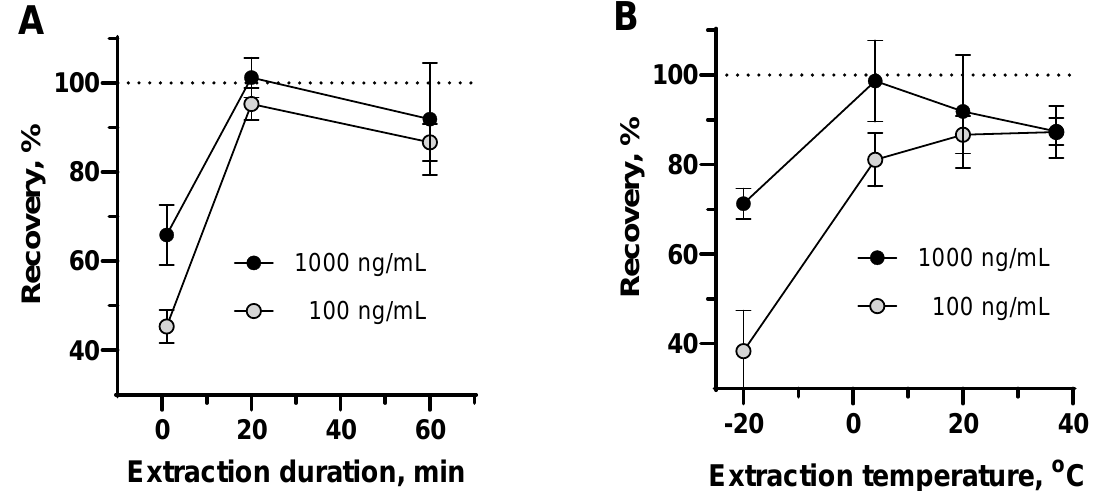
Figure 5. The influence of the duration and temperature of methanol extraction on NAT recovery from beer samples. The extraction procedure for samples fortified with NAT at 1000 and 100 ng/mL was carried out at 20 ◦ C ( A ) and for 1 h ( B ); each point is presented by average and standard deviation ( n = 4).